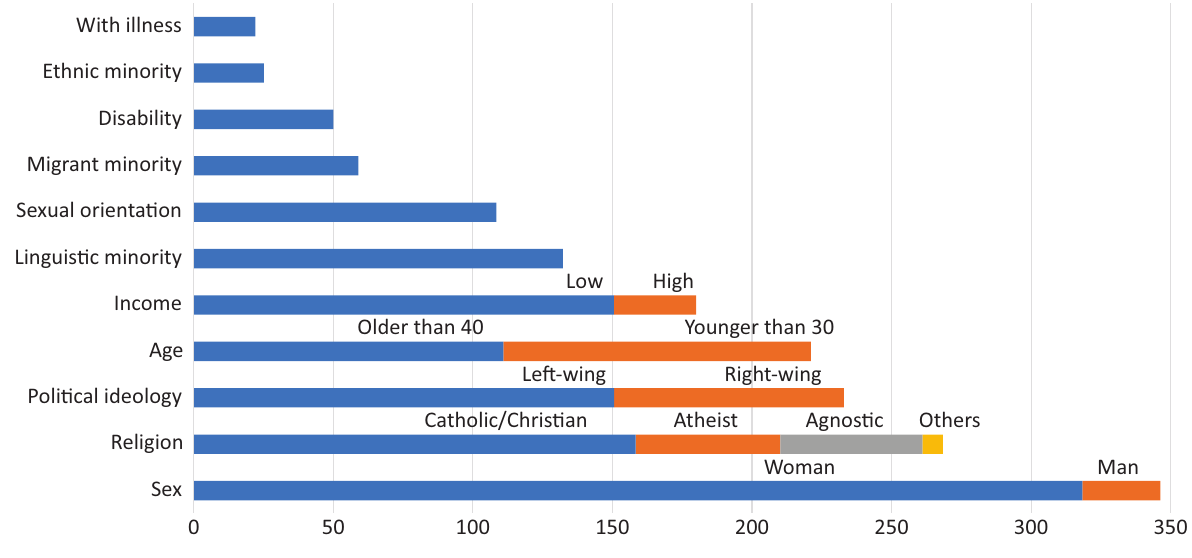
Figure 2. Discrimination. Created from the data in Table